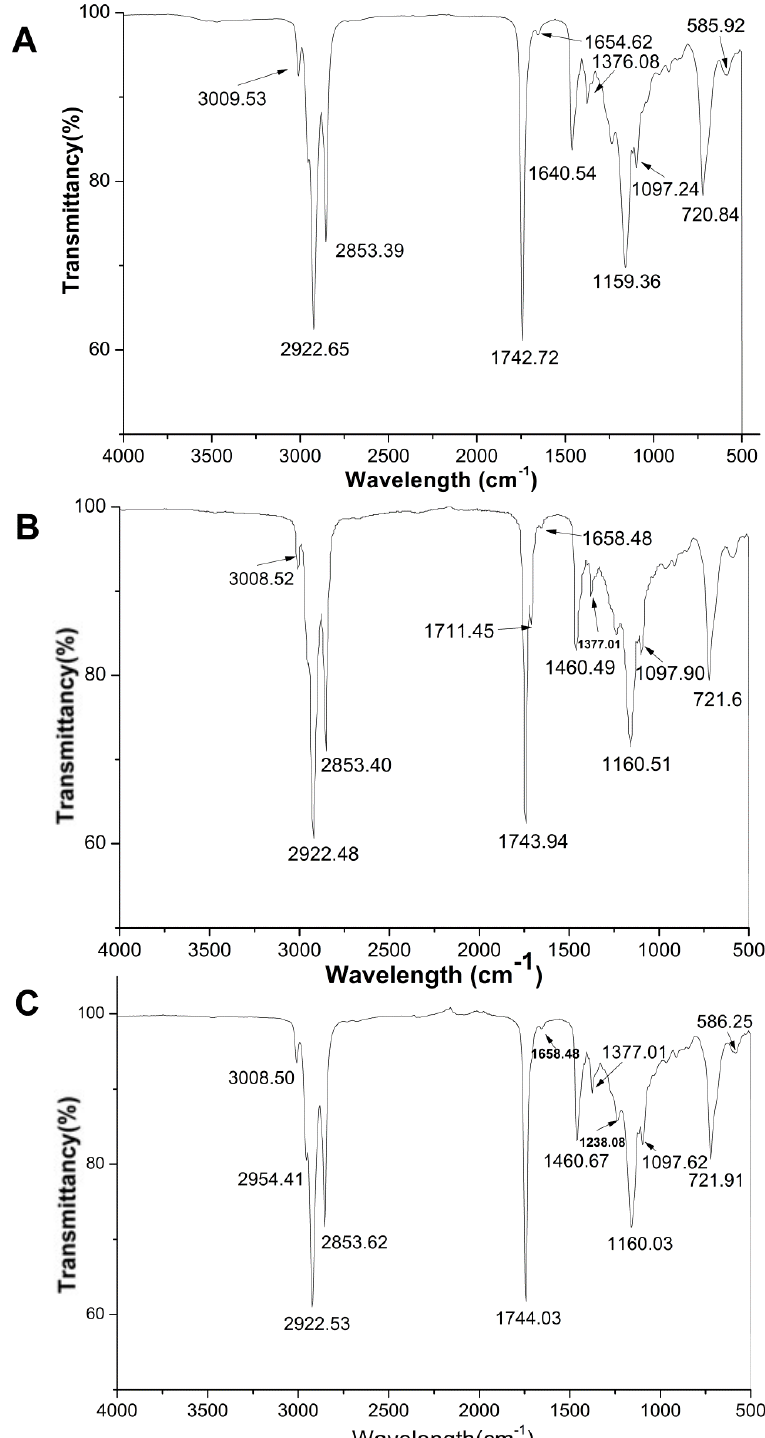
Figure 2. Infrared spectra of seed oils obtained from three types of Chenopodium quinoa Wild seed oils ( A , white; B , red; C , black).